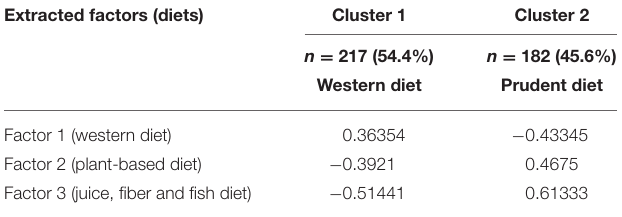
TABLE 3 | Identified clusters of dietary patterns. TABLE 4 | MedDiet questionnaire food items consumption.